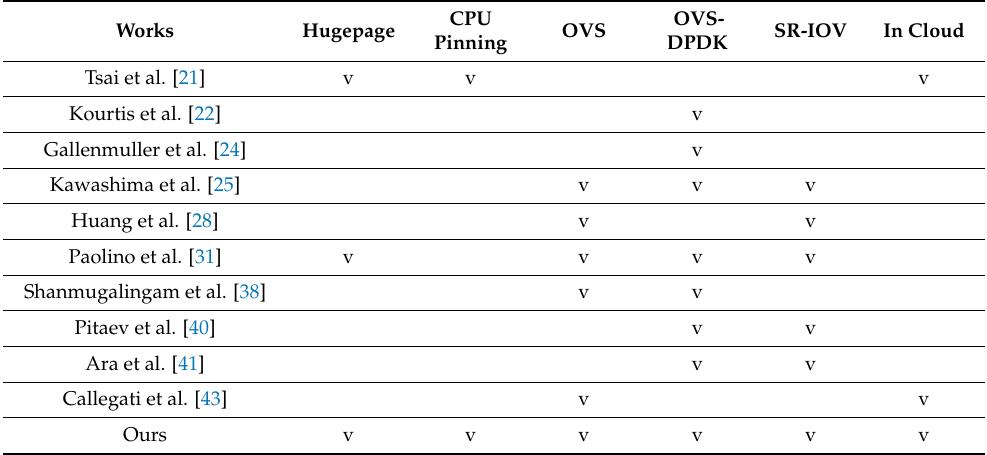
Table 1. Summary of related works.